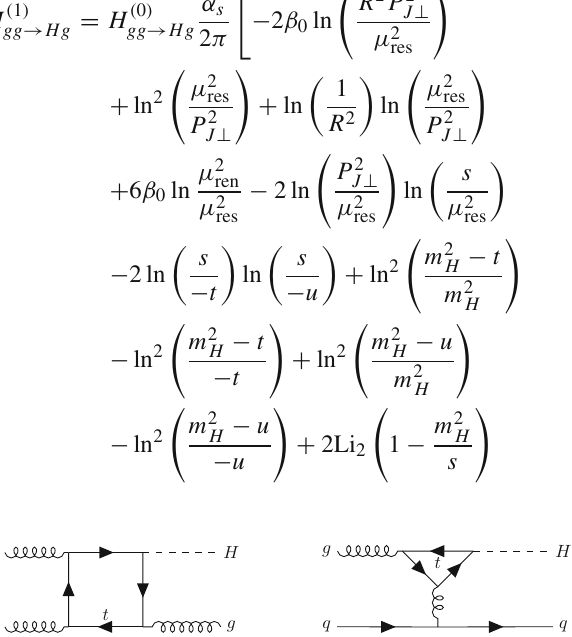
Fig. 2 Two examples of the lowest order partonic scattering diagram for H + jet